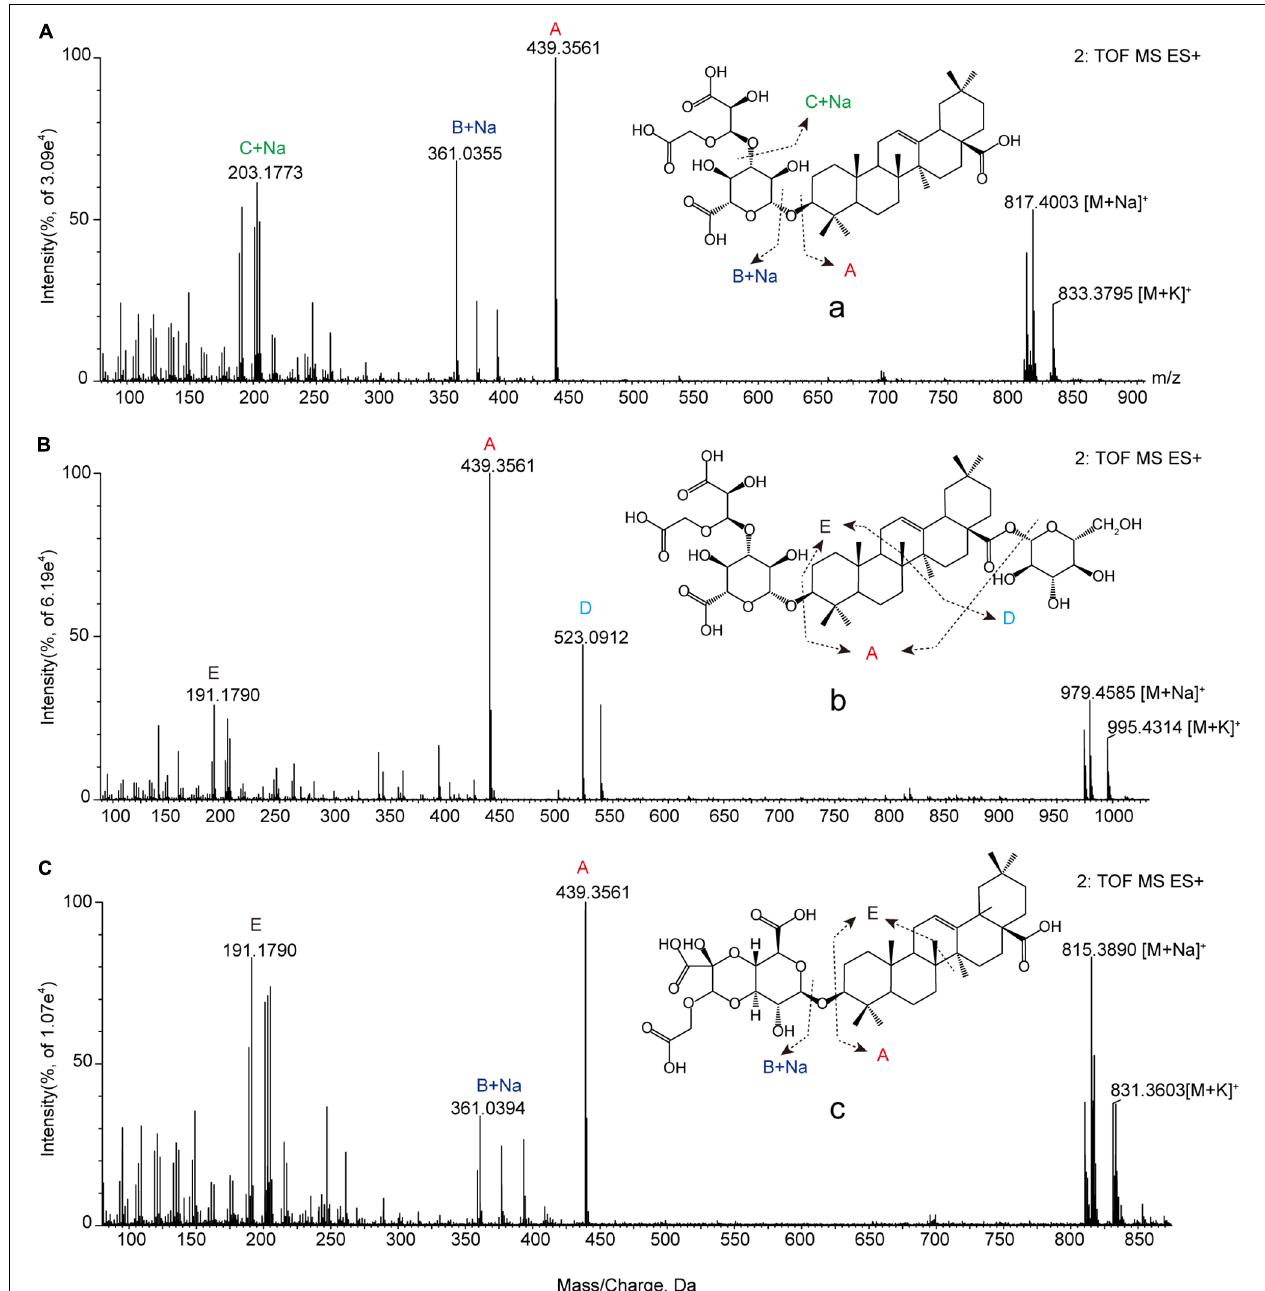
FIGURE 3 | The positive MS/MS spectrum of characteristic chemical markers. (A) Marker a (Betavulgaroside IV); (B) marker b (Betavulgaroside III); (C) marker c (Betavulgaroside II).